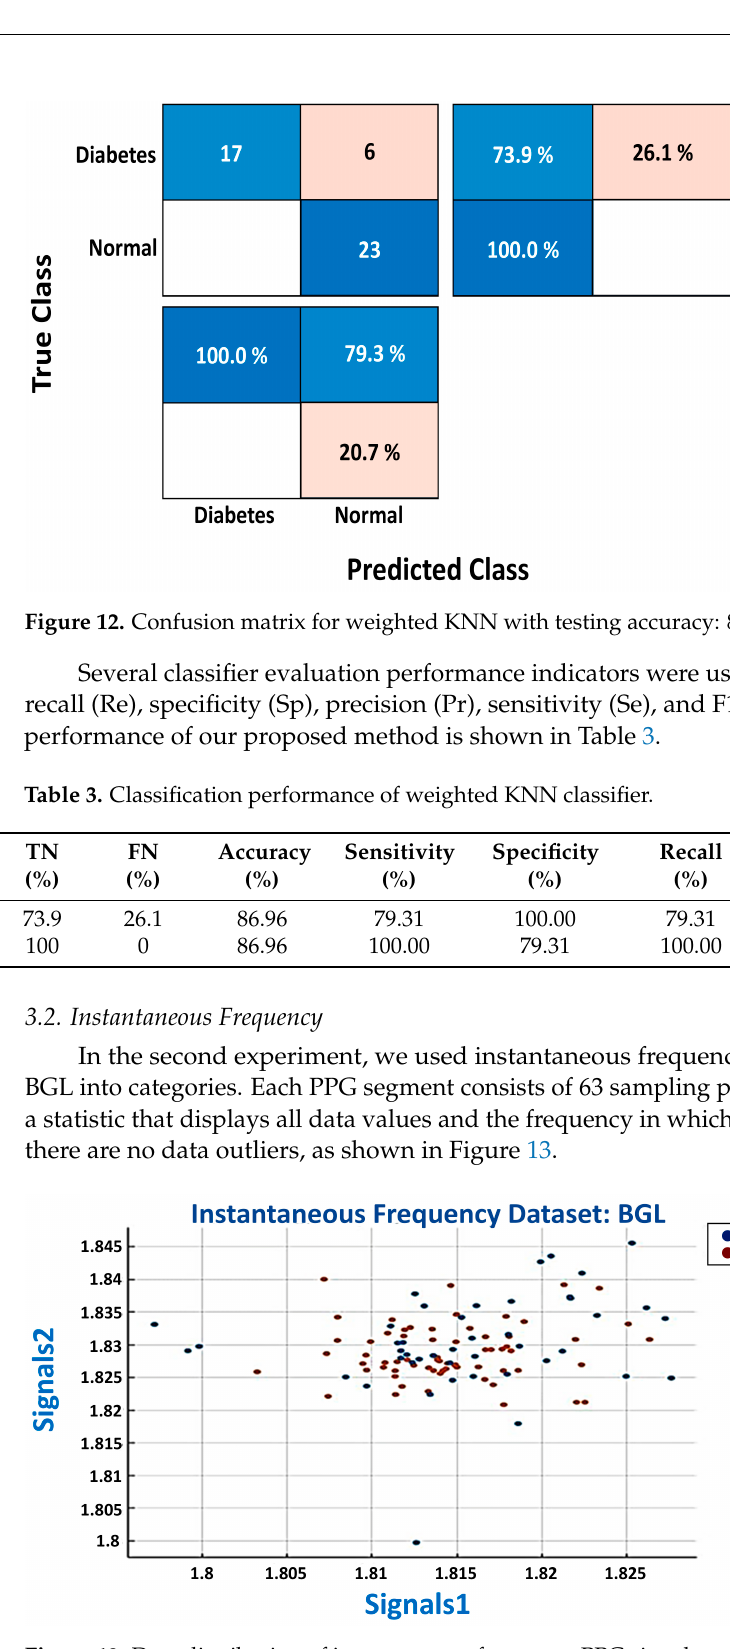
( b ) Figure 11. ROC curve for the weighted KNN classifier during training: ( a ) positive-class diabetes